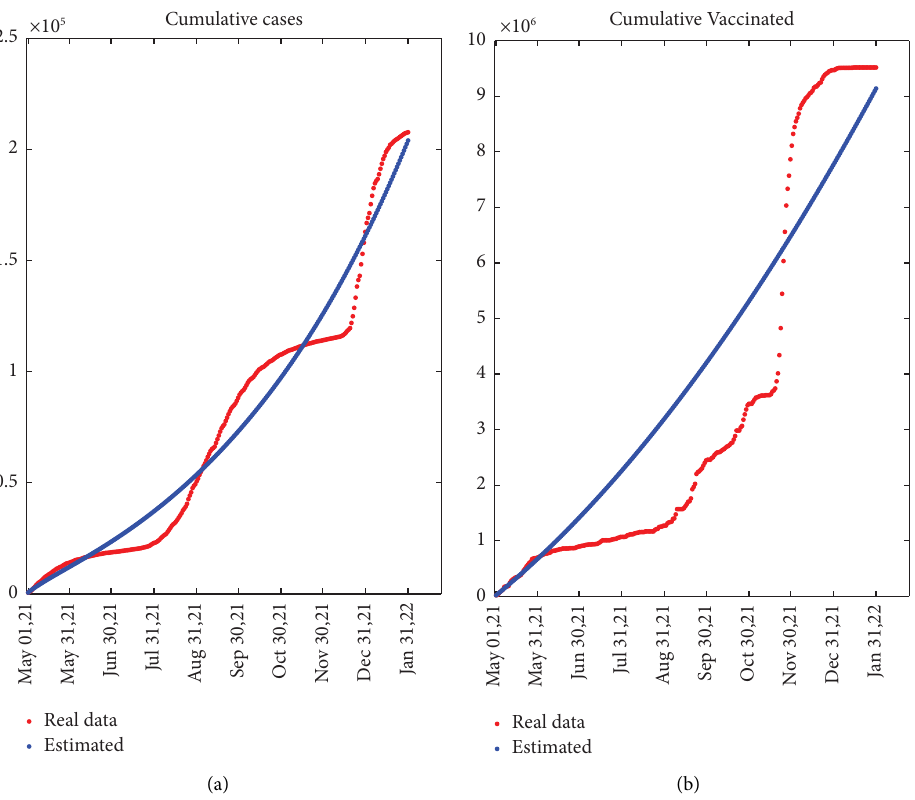
Figure 4: Te ftted data to the reported cumulative cases (a) and cumulative vaccinated (b) using the model (2) for Ethiopia from May 01 , 2021 to January 31 ,